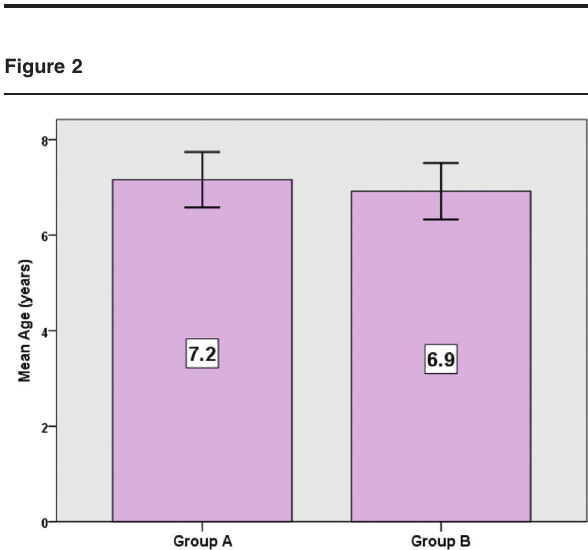
The main site for adenoid residual was the adenoid bed.